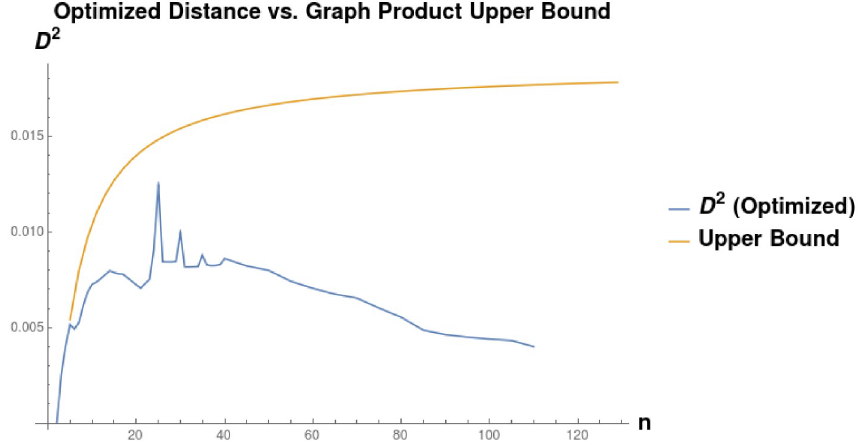
Fig 11. Comparison of the distance D (Sq n , Sq n +1 ) as a function of n , to the upper bound calculated as the optimum of distance between Pa and Pa . We see that the upper found converges to some constant D � 0.01782, n n +1 whereas the actual distance appears to be converging to 0 as n ! 1 .